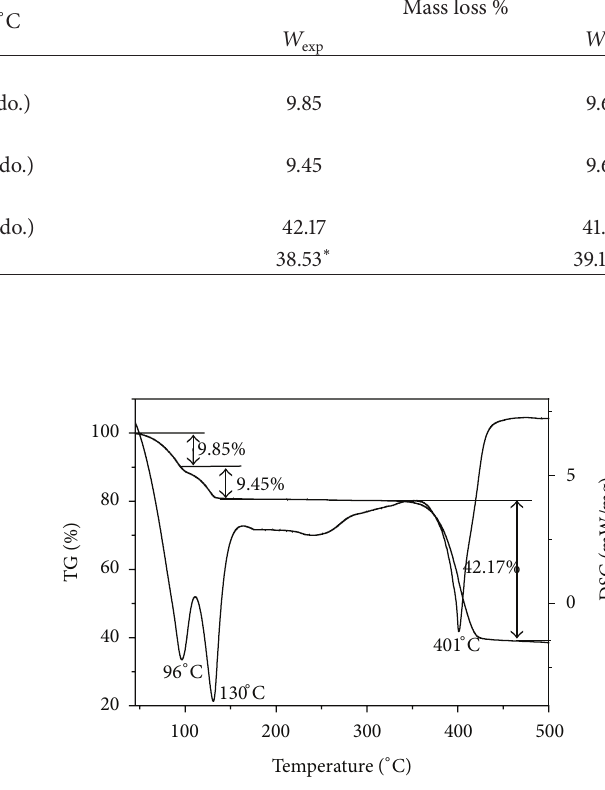
Figure 8: TG-DSC curves of the title